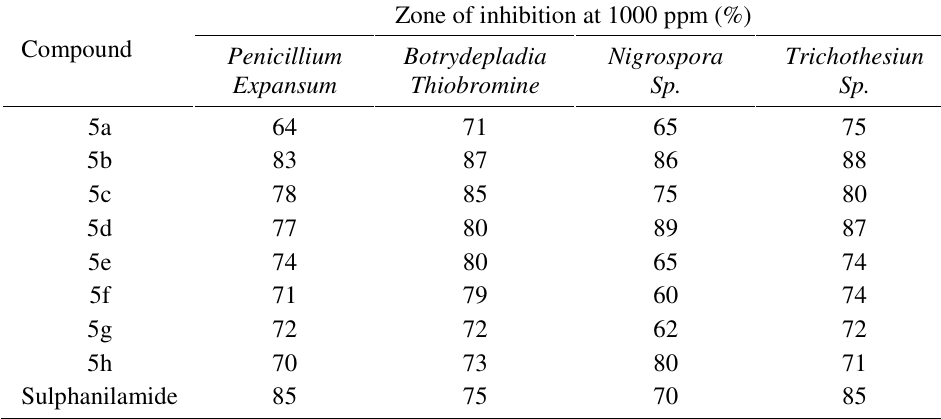
Table. 4 Antifungal Activity of compounds